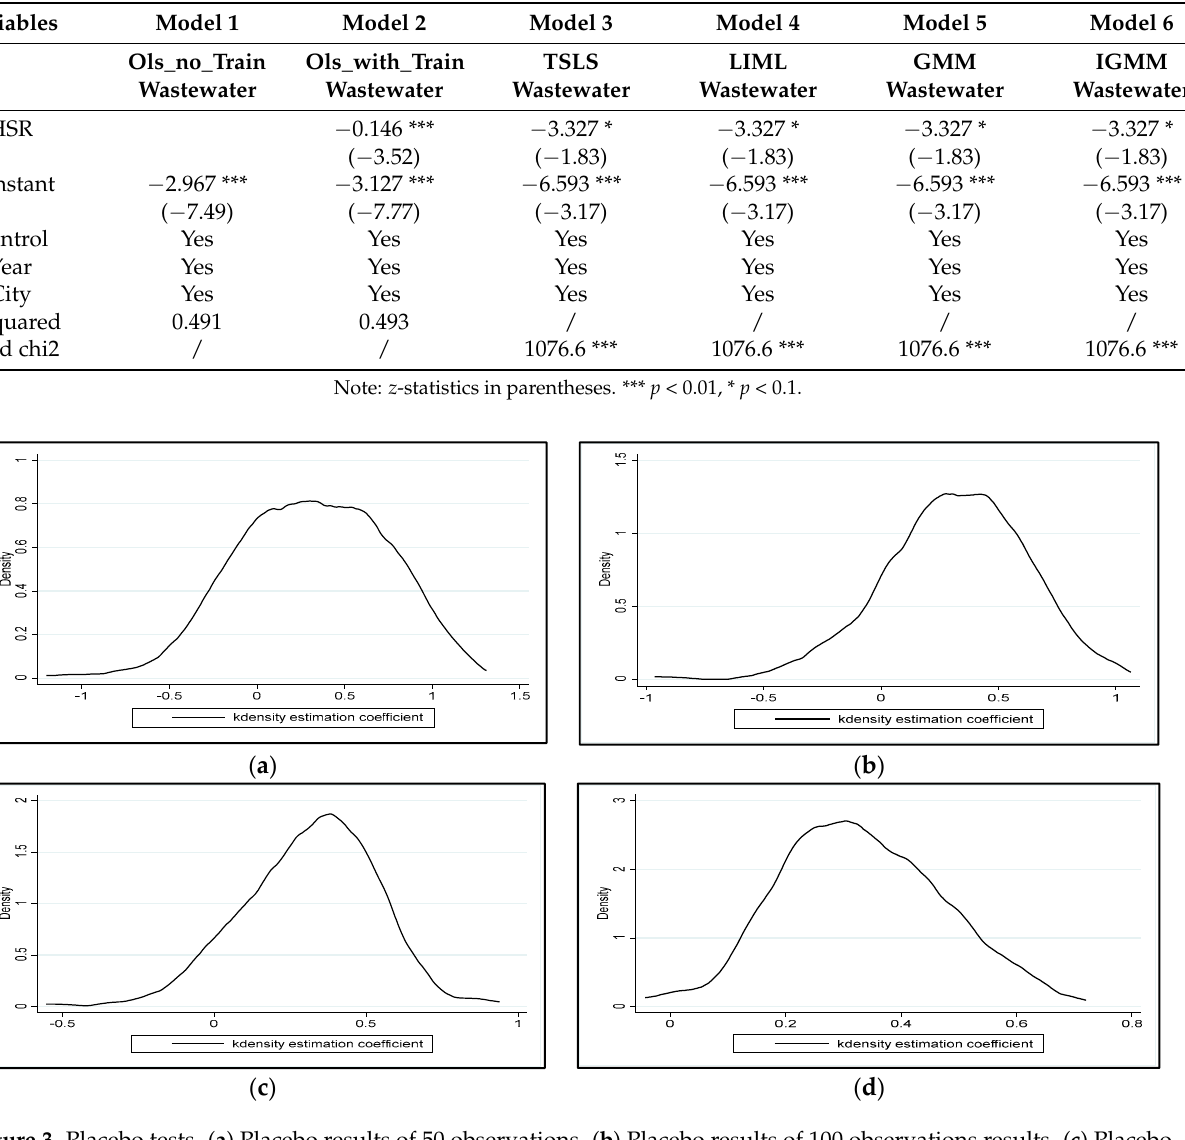
Figure 3. Placebo tests. ( a ) Placebo results of 50 observations. ( b ) Placebo results of 100 observations results. ( c ) Placebo results of 200 observations results. ( d ) Placebo results of 400 observations